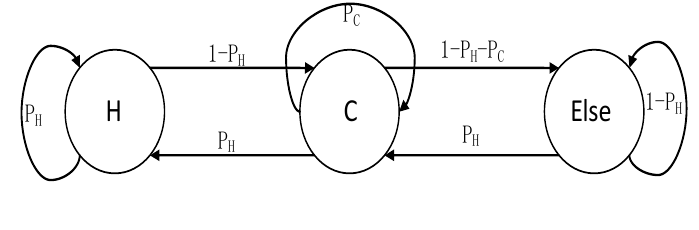
Figure 2. Change of the State of a